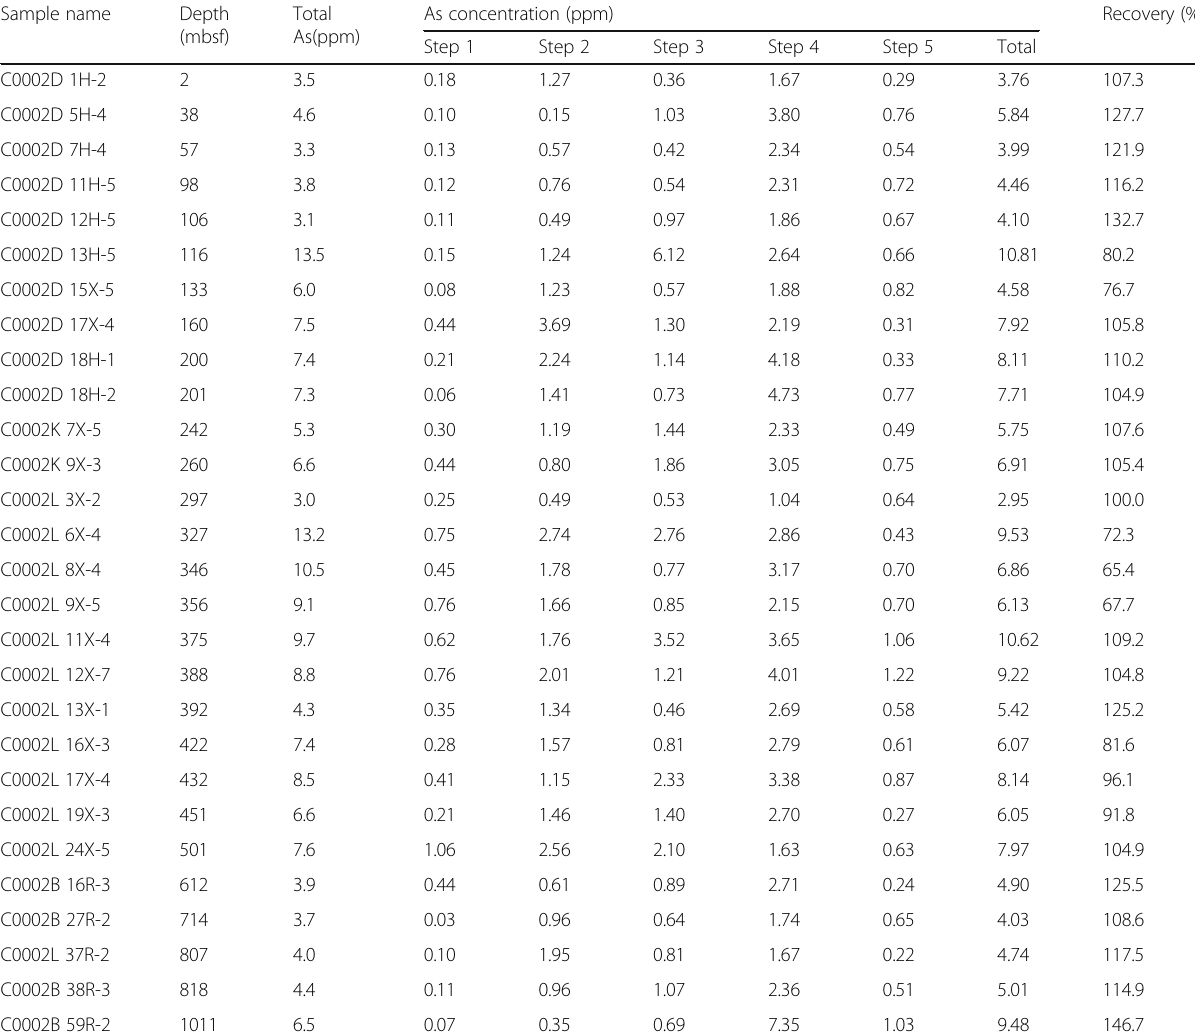
Table 2 Arsenic concentrations of sequentially extracted fractions of sediments from Site C0002 at Nankai Trough Sample